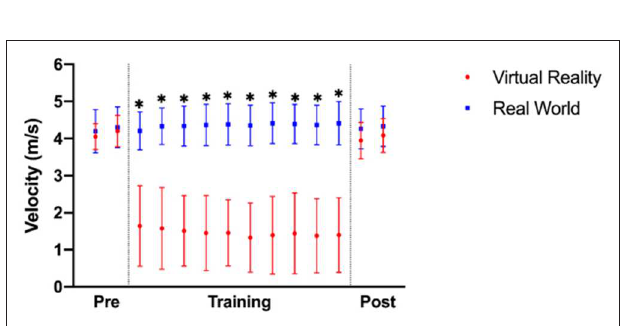
FIGURE 7 | Peak dart-throwing velocity for participants trained in virtual reality (VR) and the real-world (RW) before (Pre), during (Training), and after (Post) training (* denotes p <